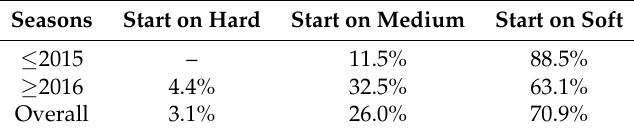
Figure 14. Progressions of the compound choice probability predictions in an example race, as outputted by the final trained NN. The compound fitted to the car at the start of the race is hard in the top plot, medium in the middle plot, and soft in the bottom plot. Table 17. Overview of tire compounds fitted at the race start. The values apply to data filtered according to Section